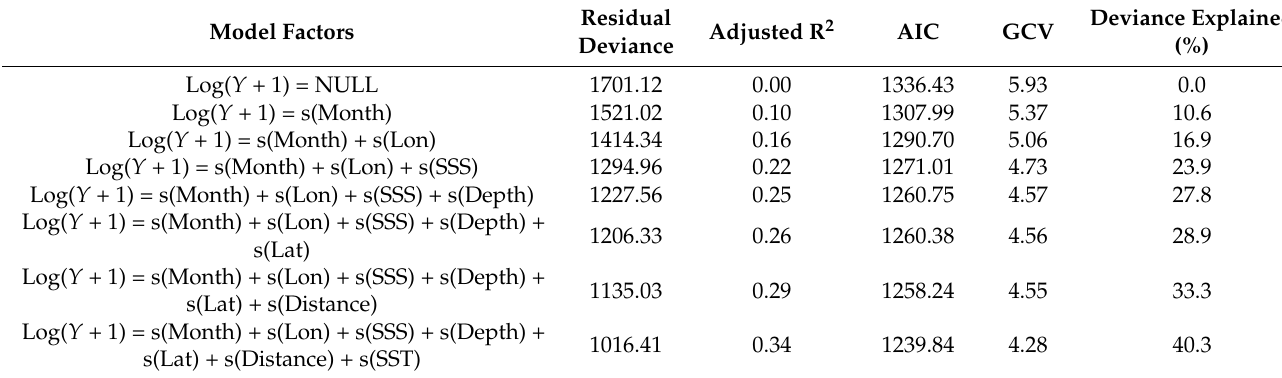
Table 3. Deviance analysis for the general additive models (GAMs) fitted to the fish larvae density. Model Factors